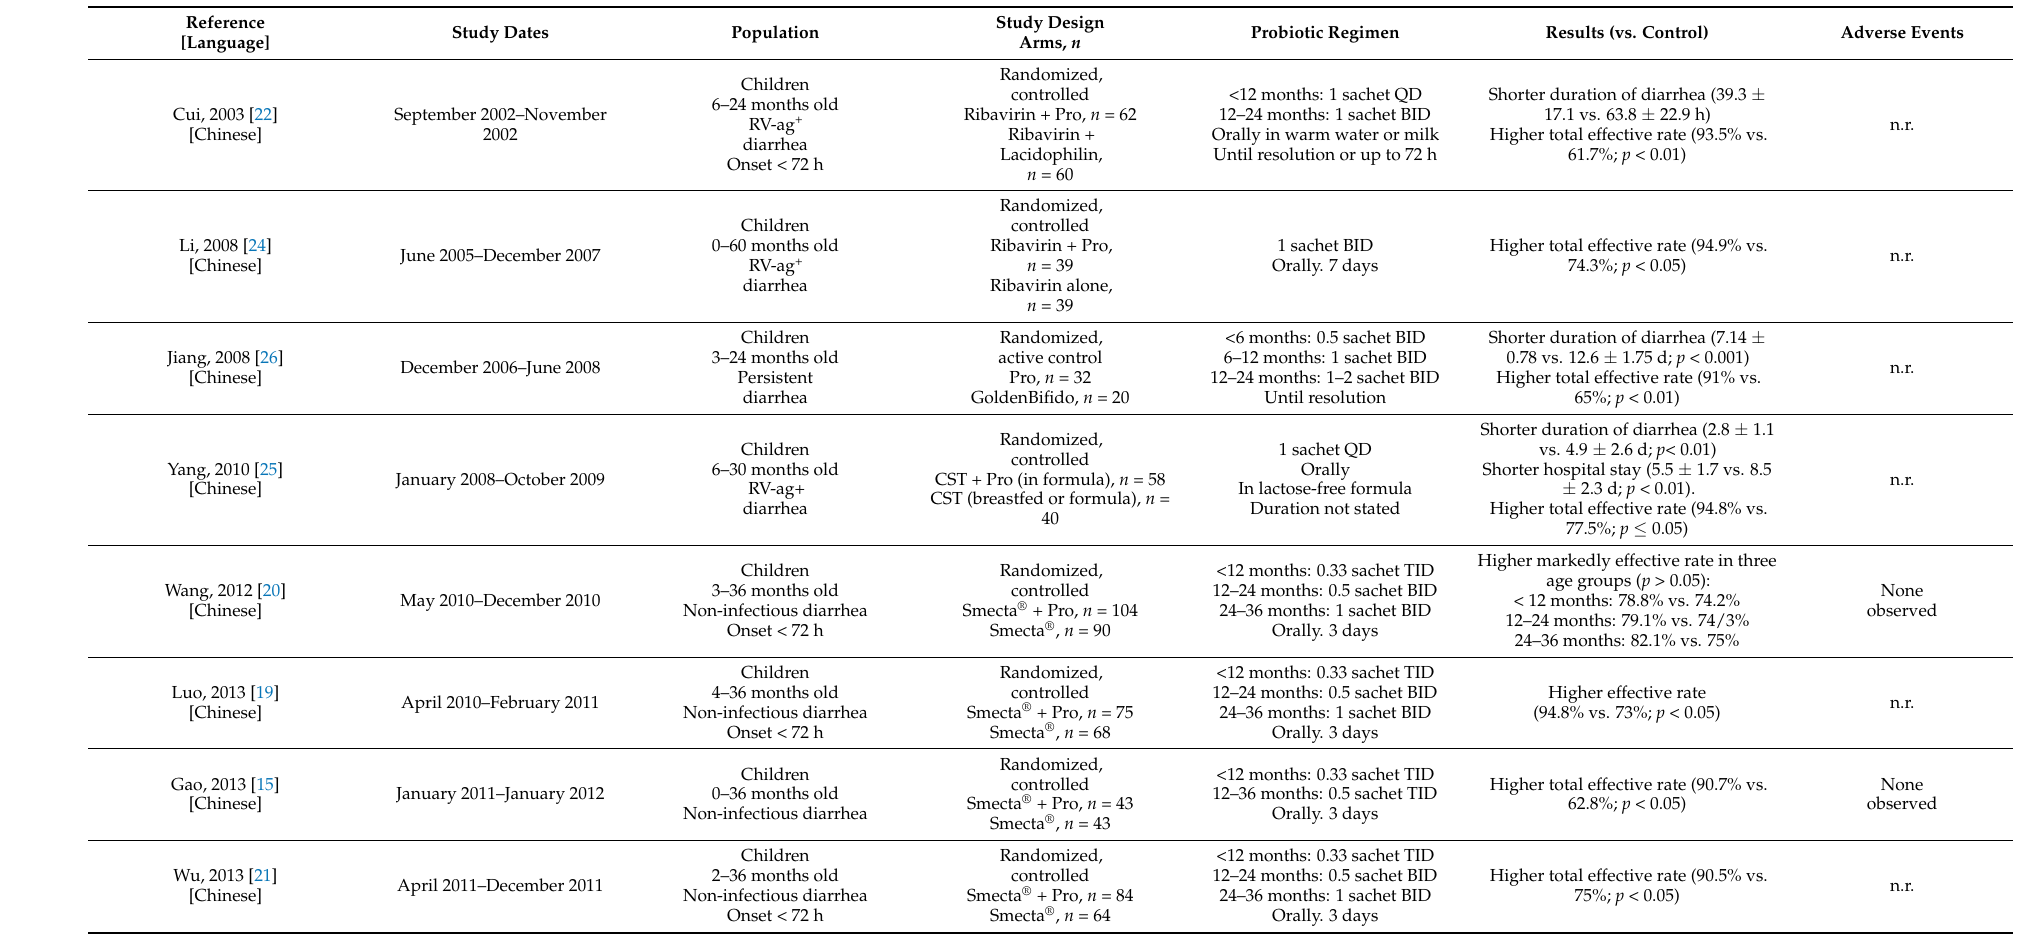
Table 2. Details of studies on diarrhea of various